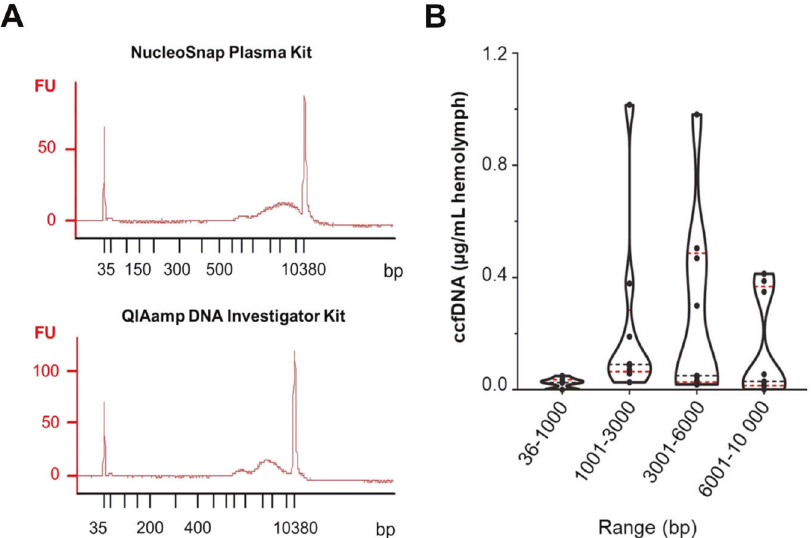
Fig. 2 Fragment size distribution of hemolymphatic ccfDNA in mussels. A Representative electropherograms of the hemolymphatic ccfDNA of Mytilus sp . extracted with NucleoSnap Plasma Kit (above) and QIAamp DNA Investigator Kit. B Violin plots showing the distribution of the hemolymphatic ccfDNA concentrations (±SE) in mussels. Black and red lines represent the median and the fi rst and third quartiles respectively.